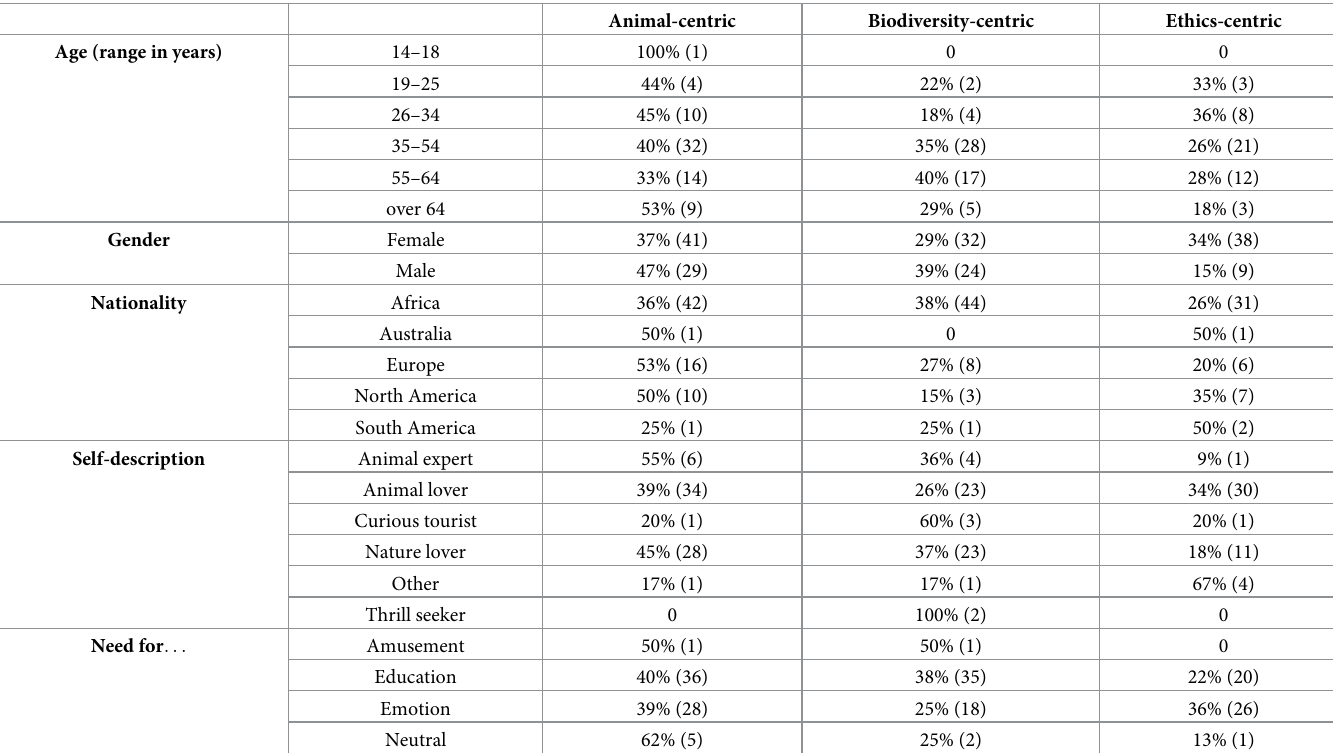
Table 4. Relation between mindset and demographic of